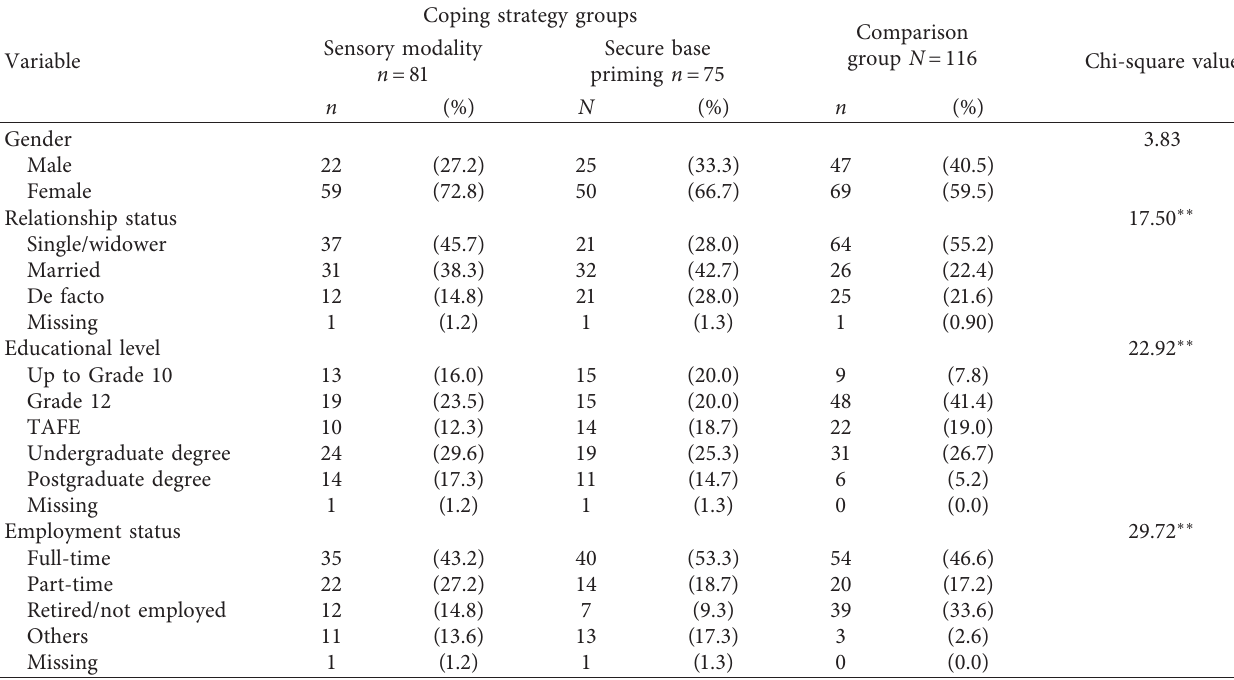
Table 1: Participant demographics according to experimental group allocation with chi-square analysis ( N � 272). Coping strategy Variable